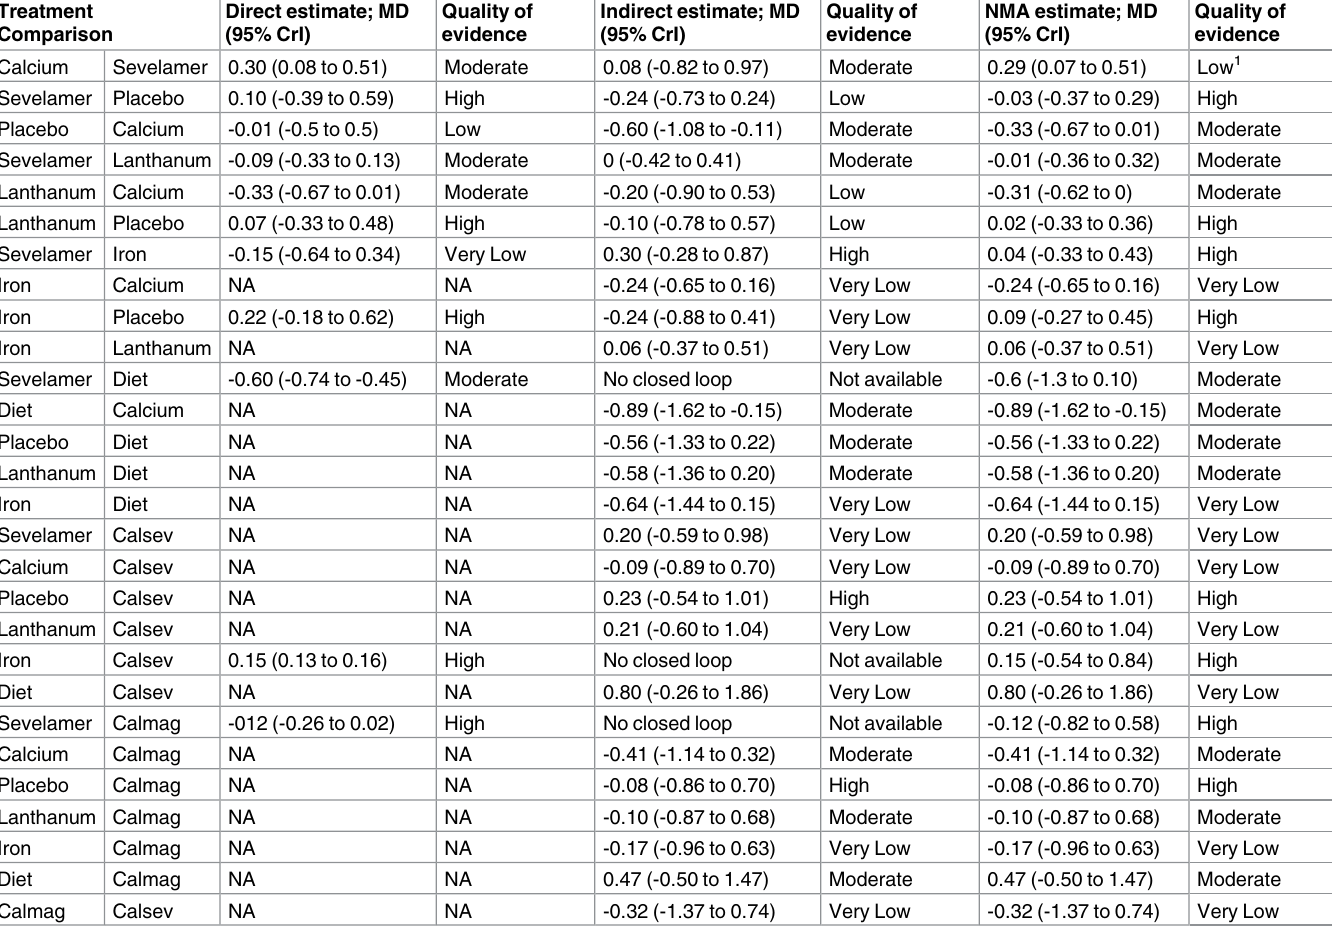
Abbreviations: CrI: Credible interval; MD: Mean difference; calmag: calcium and magnesium; calsev: calcium and sevelamer; calsevlant: calcium or sevelamer or